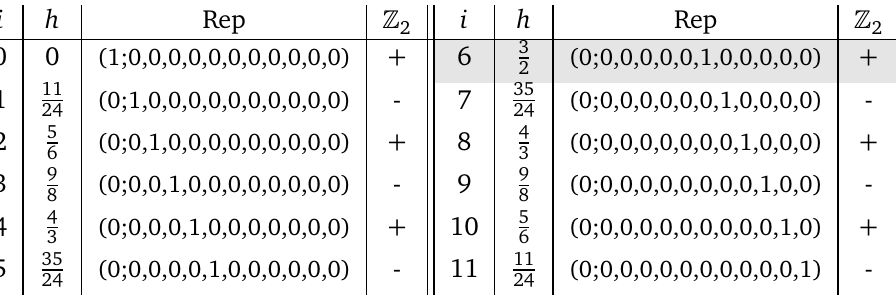
Table 6: SU ( 12 ) : primaries labeled by i are characterized by weights h and SU ( 12 ) Dynkin la- 1 ( τ ) . We highlight the primary related to the (cid:90) bels. Their characters are denoted by χ i of center symmetry (cid:90) 12